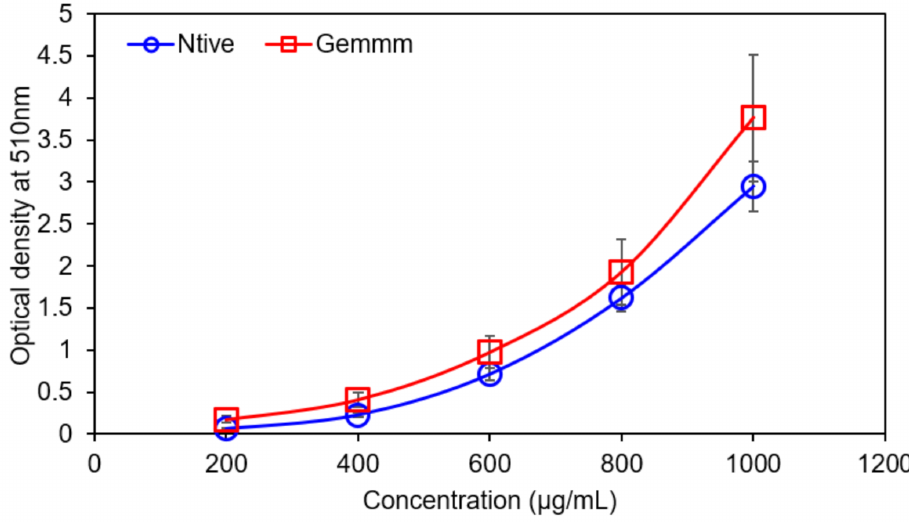
Figure 3. Total Flavonoid Contents of Native and gemm extracts of H. griffithi . TPC was determined by the gallic acid equivalent (GA). Appearance of red colour indicates the presence of flavonoids and both extracts H . griffithii (native and gemm extracts) have variation in the TPC. Maximum phenolic contents 97 mg/g were found in gemm extracts. The comparison between both H . griffithii (native and gemm extracts) indicated that gemm forms rich source of TPC (Figure 4). Both TPC and TFC have antioxidant potential due to their stable radical intermediates and e - donating ability of H 2